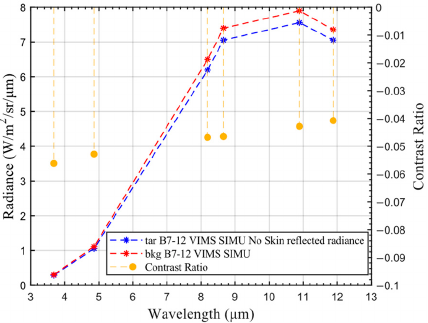
Figure 9. B7–12 radiance comparison of aircraft and background simulated without the skin reflected radiance. The left axis is the radiance, and the right axis is the contrast, where the negative number means that the target radiance is lower than the background radiance.